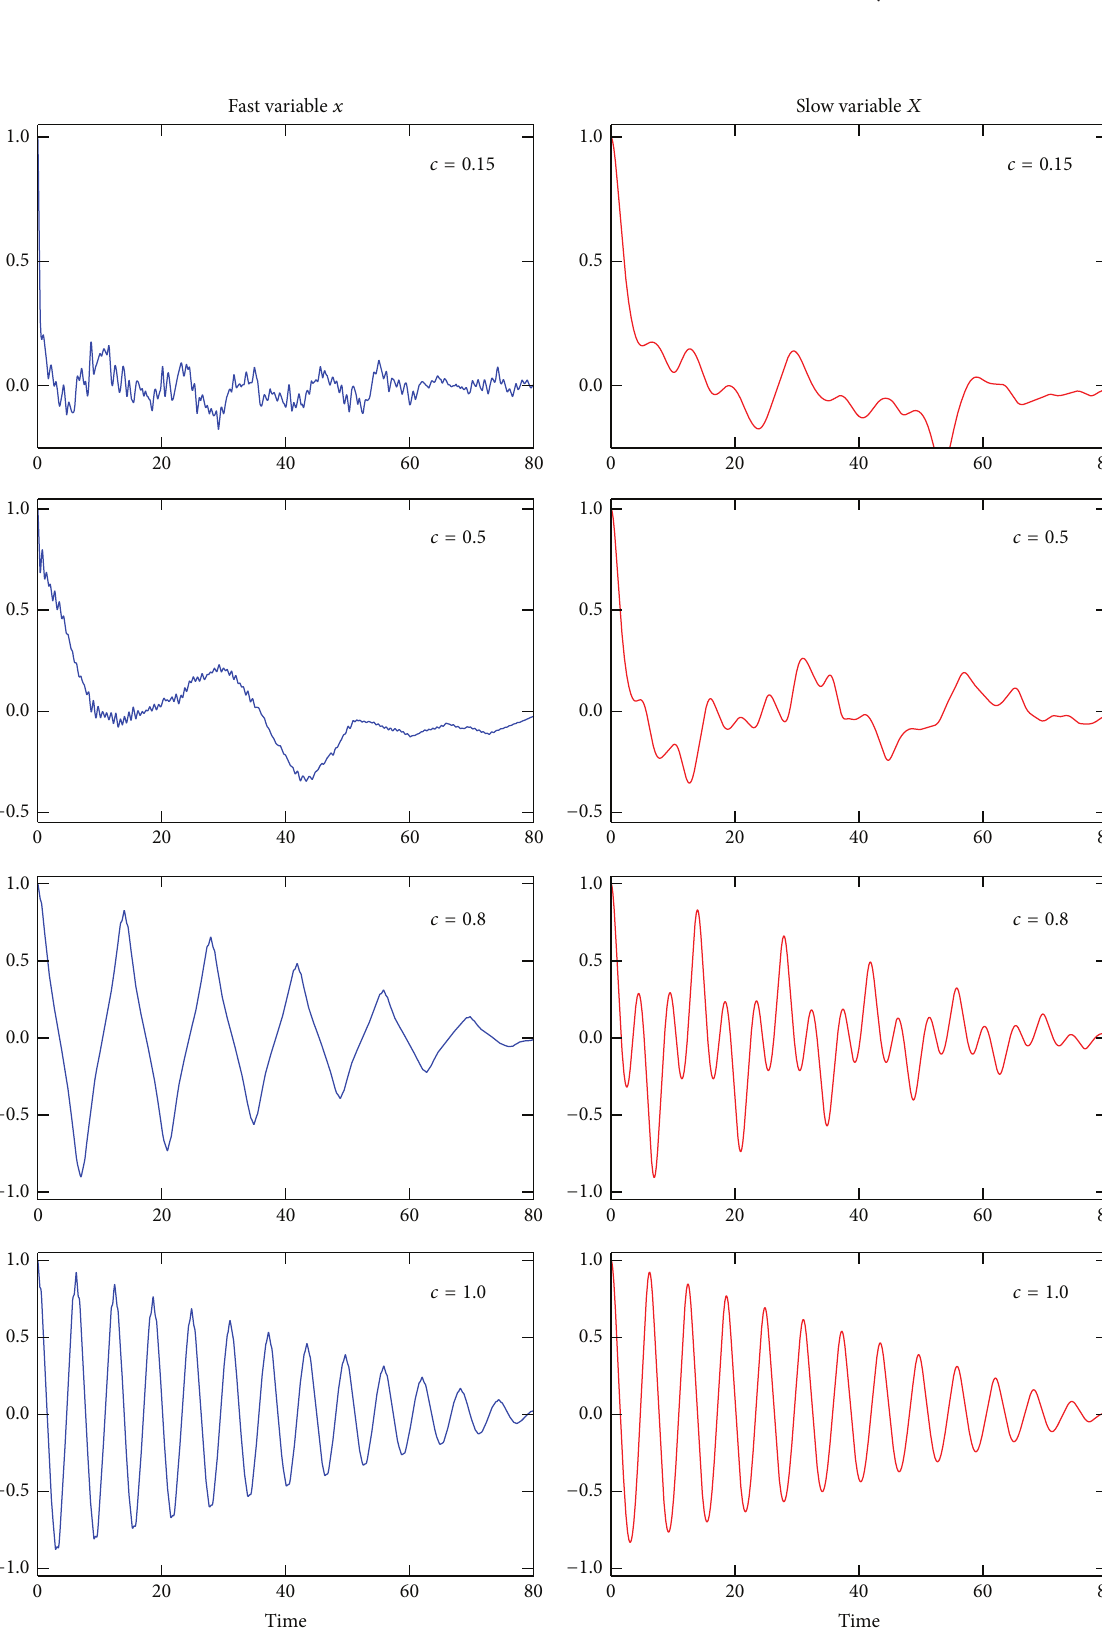
Figure 6: Autocorrelation functions for dynamic variables 𝑥 and 𝑋 for different parameter 𝑐